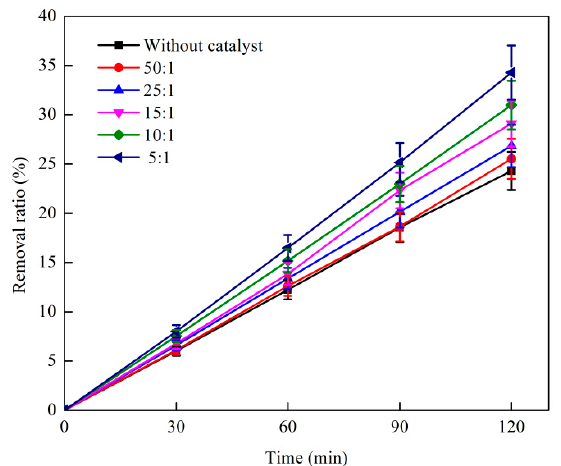
Figure 2. E ff ect of catalyst dosage ratio on coking wastewater treatment by O 3 catalytic Figure 2. Effect of catalyst dosage ratio on coking wastewater treatment by O 3 catalytic oxidation.